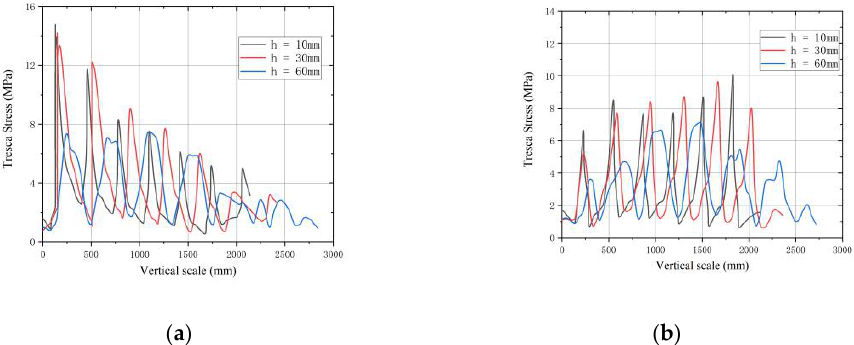
Figure 14. Distribution of Tresca stresses in grout along steel walls. ( a ) Stresses along the inner wall. ( b ) Stresses along the outer wall.